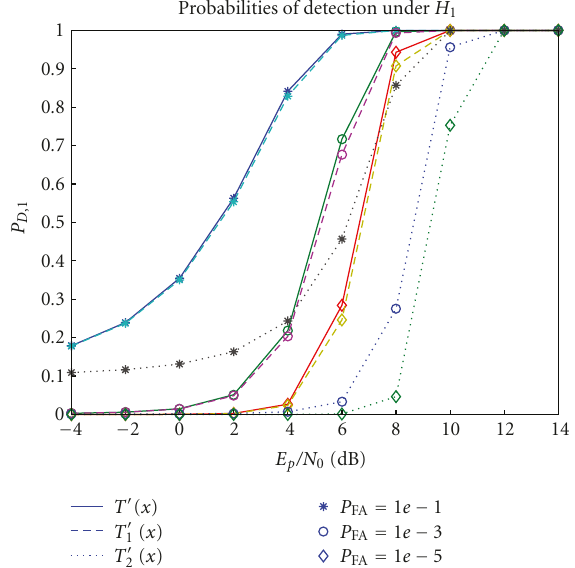
Figure 4: Performance comparison between T (cid:13) ( x ) and its compo- nents T (cid:13) 1 ( x ) and T (cid:13) 2 ( x )